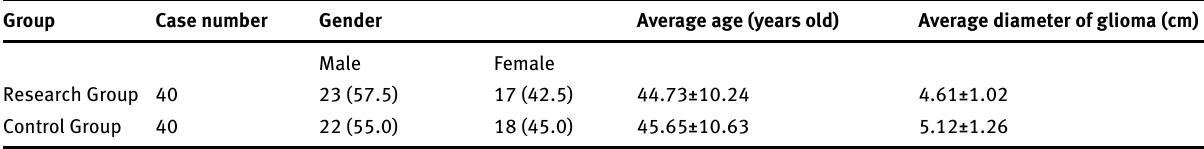
Table 1 Comparison of general situation between patients of the two groups